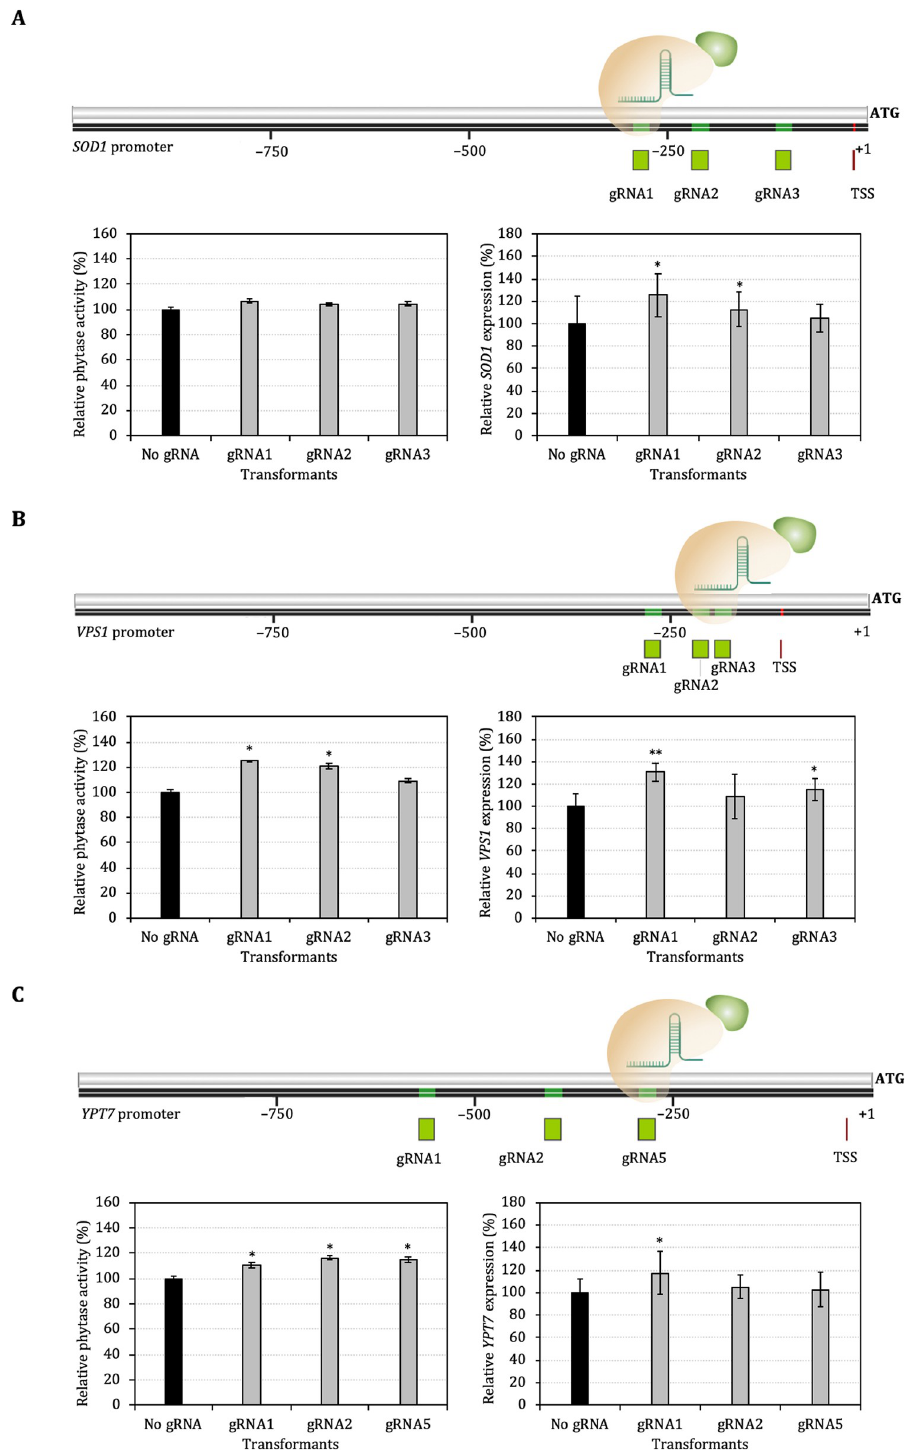
Fig 4. Targeting CRISPR-dCas9 to sequences upstream promoter of SOD1 (A), VPS1 (B) and YPT7 (C) and relative activity of phytase activity (%U/OD) and relative gene expression level (%fold change) in recombinant yeast harboring CRISPR-dCas9 system. Data are shown as mean ± S.D. from three-independent biological replicate experiments ( n = 3). ACT was used to normalize gene expression. TSS is a putative transcription start site. Asterisks ( � ) indicate significantly altered expression profiles relative to the control Ot-dCas9-VP64 without gRNA (No gRNA) ( � p < 0.05 and �� p < 0.01).